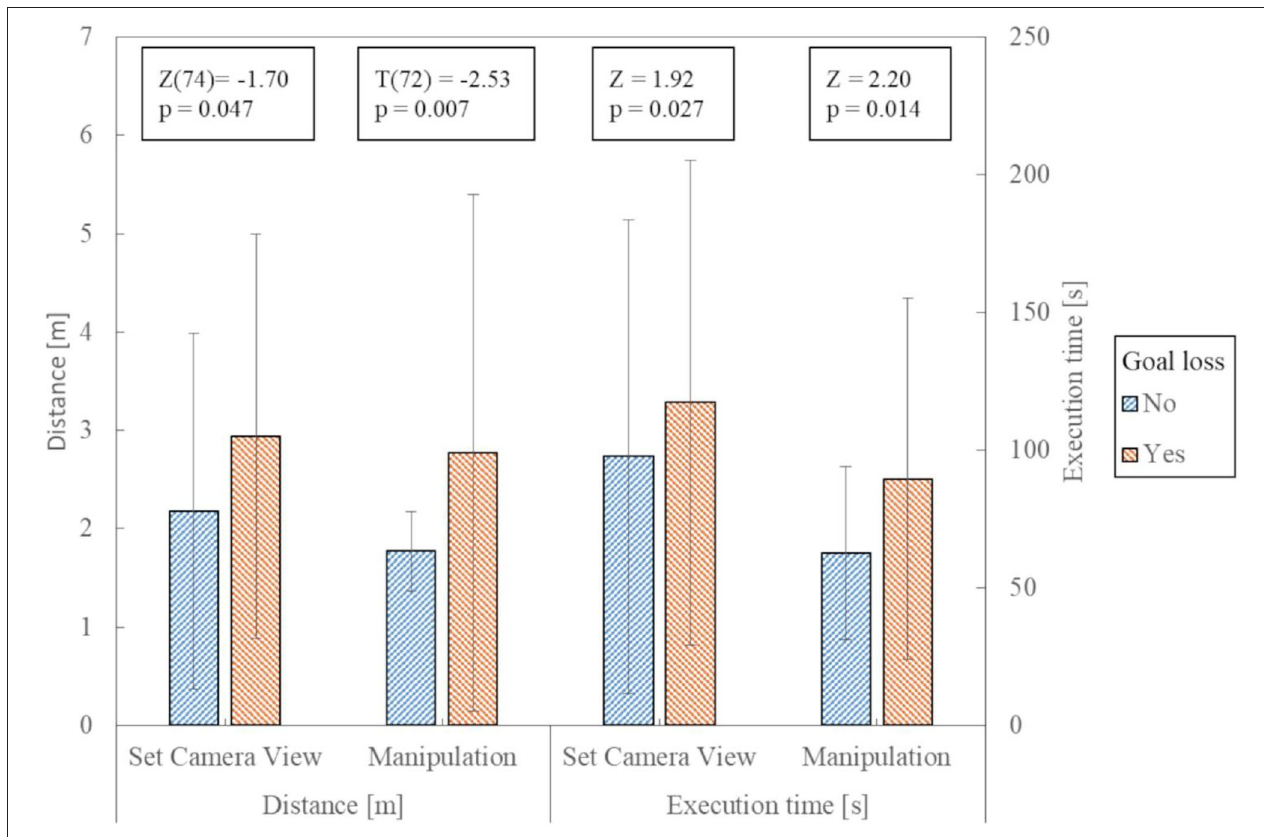
FIGURE 11 | Comparison of the trajectories concerning temporal and spatial length. The error bars show the standard deviation. The Z/T and p -values apply to the comparison of the data under them.